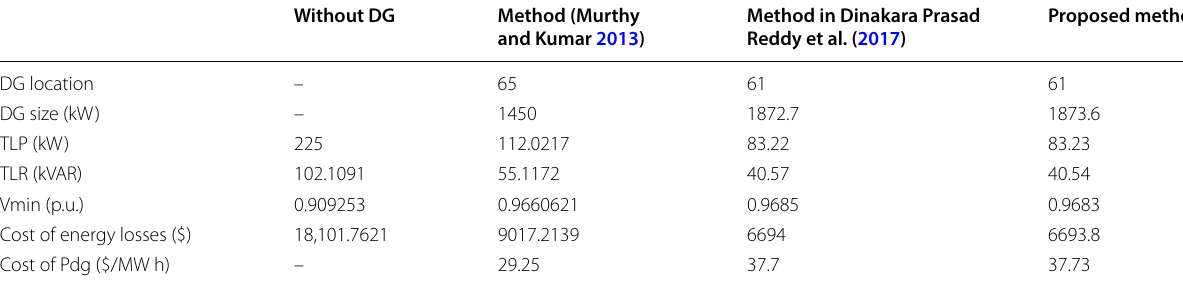
Table 7 Results for 69-bus system with DG at upf